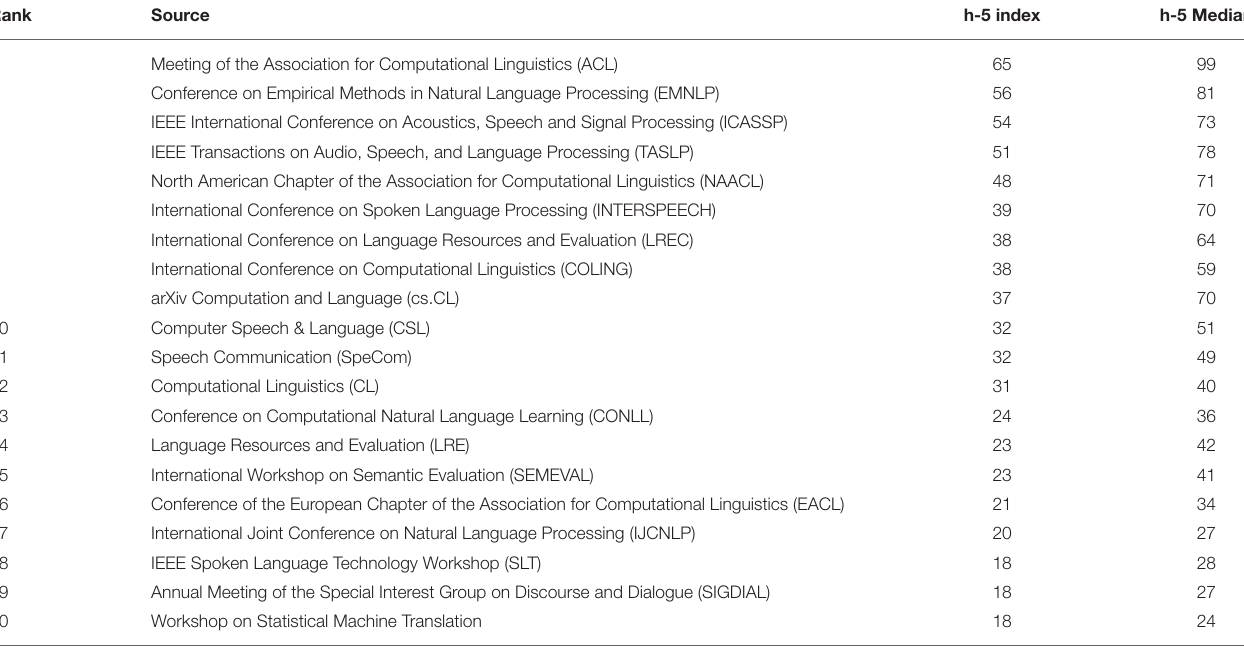
TABLE 15 | Ranking of 20 top sources according to Google Scholar h5-index over the 5 last years (2011–2015). Rank Source h-5